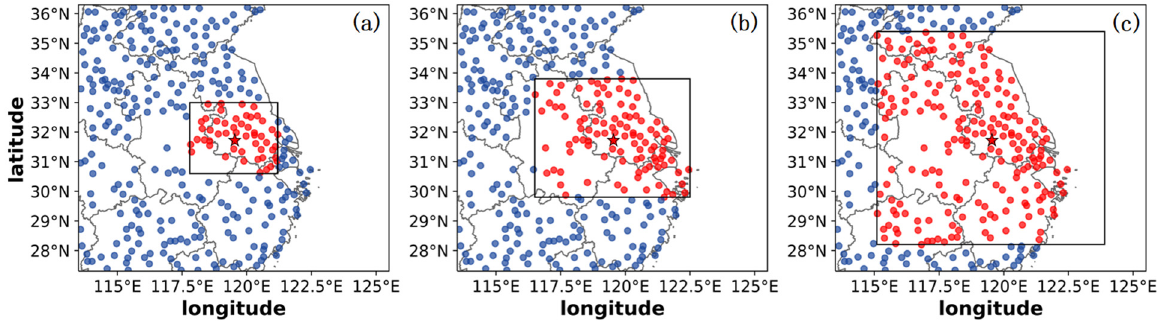
Figure 10. Sub ‐ domains containing 51 ( a ), 101 ( b ), and 199 ( c ) station sites for N ‐ exps. The red star Figure 10. Sub-domains containing 51 ( a ), 101 ( b ), and 199 ( c ) station sites for N-exps. The red star is is the station “Jintan”. the station